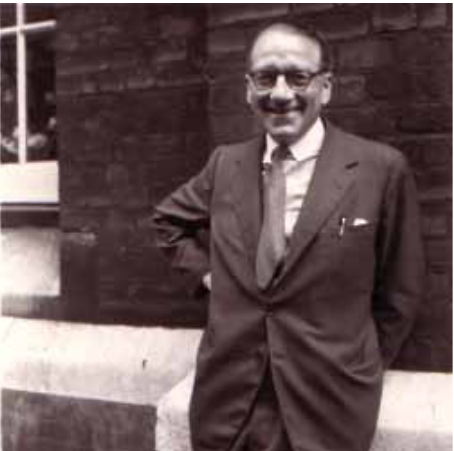
Fig. 3: Maurice ‘Cookie’ Cookson (image courtesy of Stuart